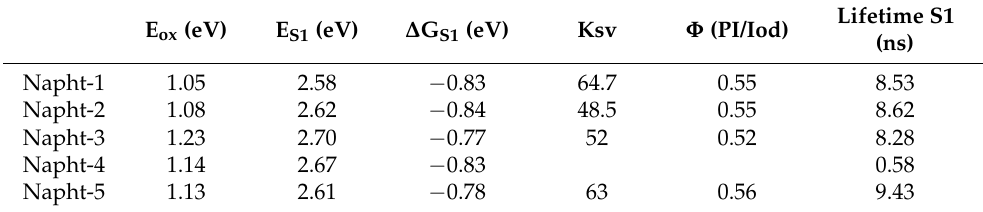
Figure 7. ( A ) Time-correlated single-photon counting of Napht-1 in chloroform, λ ex = 367 nm, λ em = 500 nm, mono-exponential curve fitting. ( B ) E S1 determination. ( C ) Fluorescence quenching of Napht-1 by Iod. ( D ) Determination of Stern-Volmer coefficient (Ksv). Table 6. Parameters characterizing the photophysical and photochemical properties of Naphthalimide compounds. For Iod, a reduction potential of −0.7 eV was used for the ΔGet calculations (E S1 stands for the energy of the first excited singlet state).